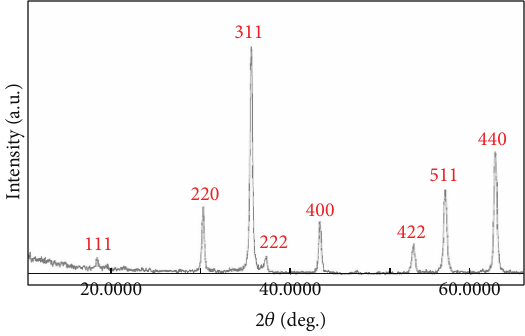
Figure 6: XRD pattern of Fe 3 O 4